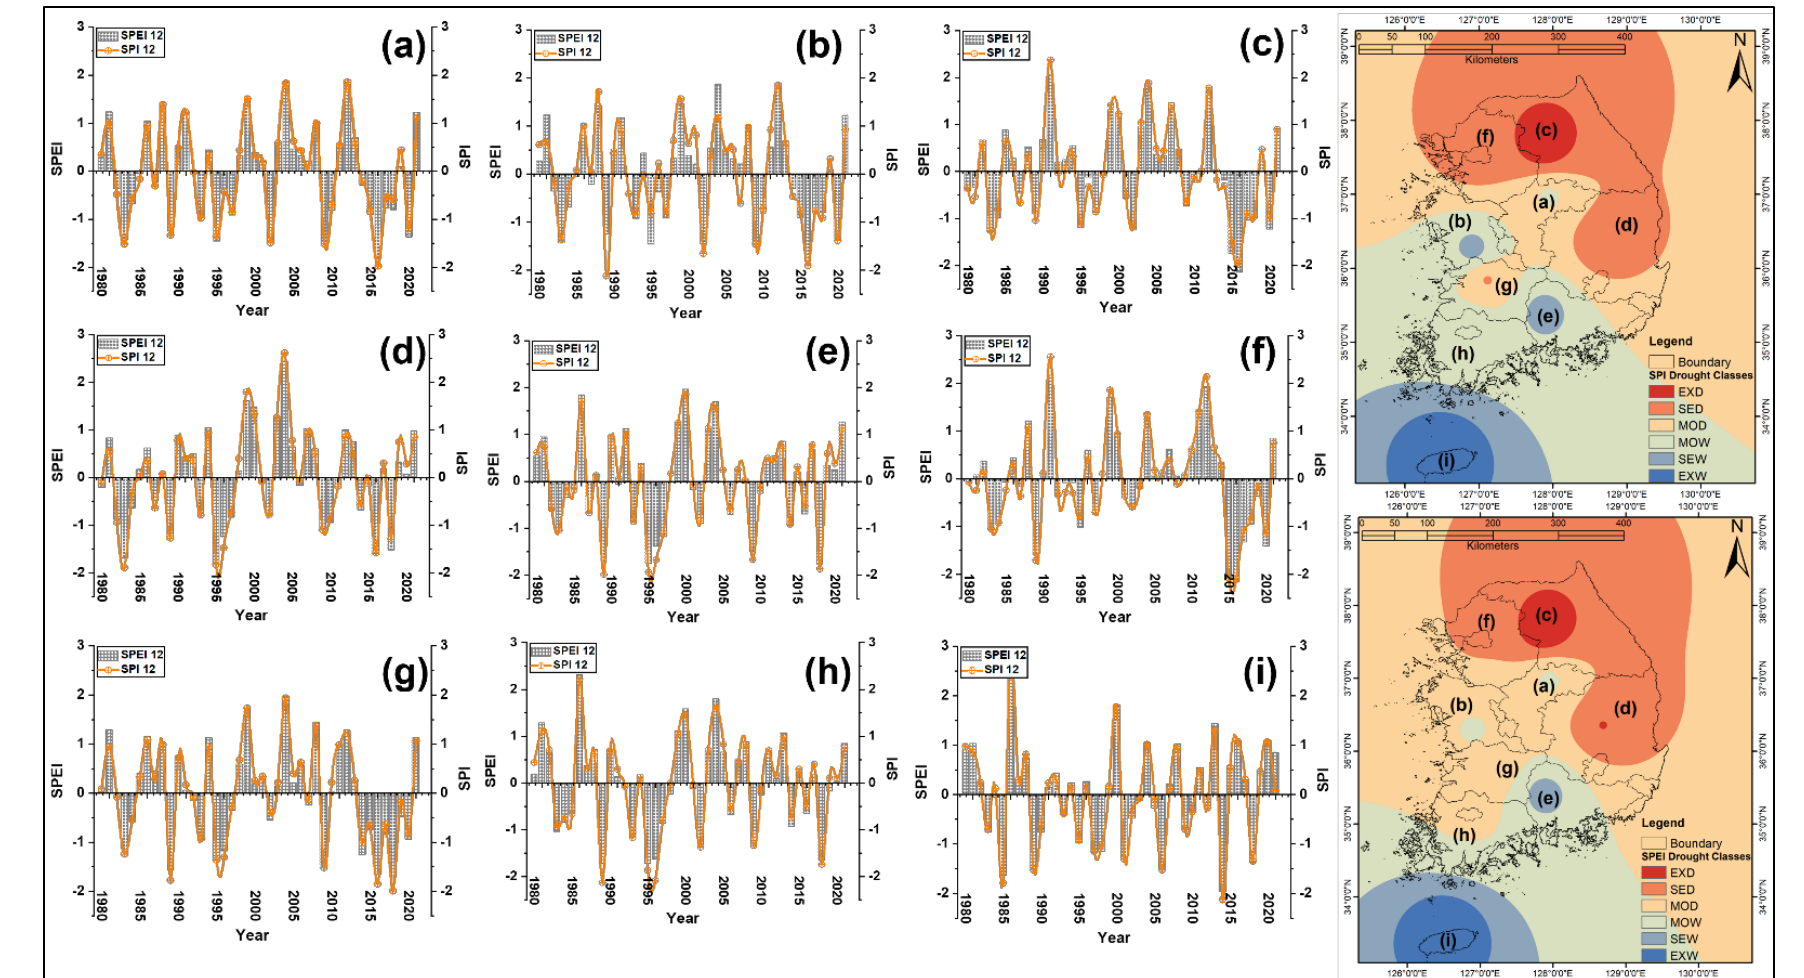
Figure 5. SPEI and SPI 12 ( a ) North Chungcheong, ( b ) South Chungcheong, ( c ) Gangwon, ( d ) North Gyeongsang, ( e ) South Gyeongsang, ( f ) Gyeonggi, ( g ) North Jeolla, ( h ) South Jeolla, and ( i ) Jeju. EXD: Extreme Drought, SED: Severe drought, MOD: Moderate drought, EXW: Extreme wet, SEW: Severe wet, and MOW: Moderate